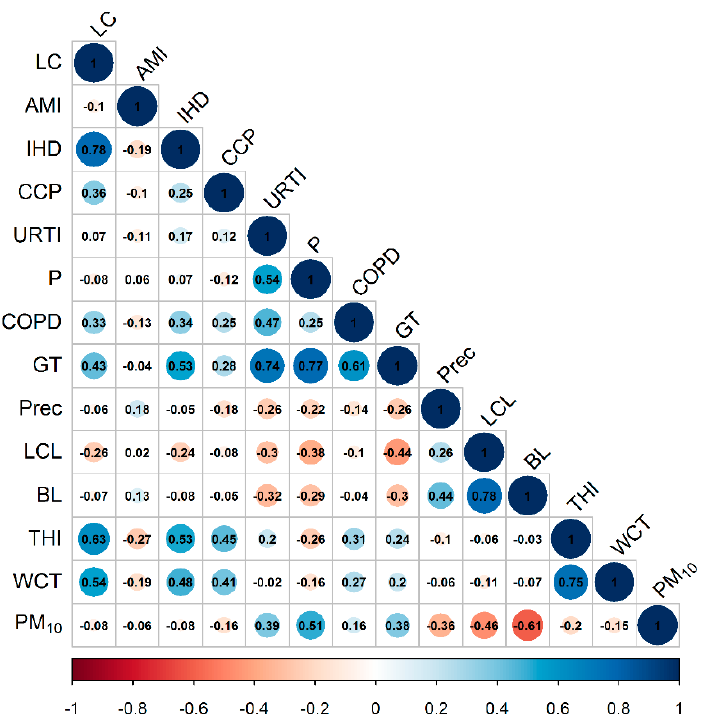
Figure 11. Pearson’s rank correlation coefficients between PM 10 , health effect and meteorological data.